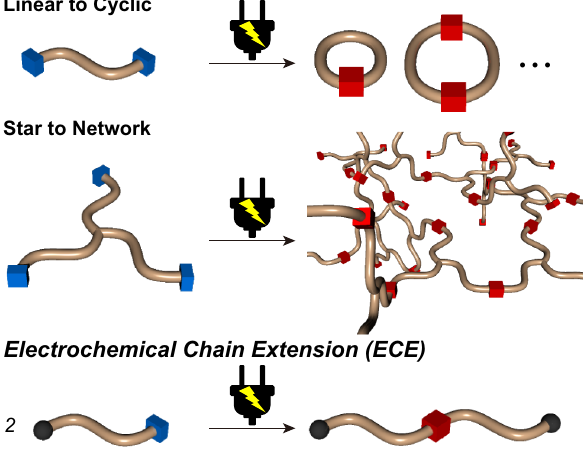
Fig. 1 Oxidation of lophines and its application for polymer synthesis. a Previous polymer – polymer coupling reaction based on oxidation of lophines utilizing chemical oxidants and electrochemical polymer – polymer coupling in this work. b Schematic illustration of linear to cyclic and star to network electrochemical topological transformations (ETTs) and chain extension (ECE) reactions reported in this